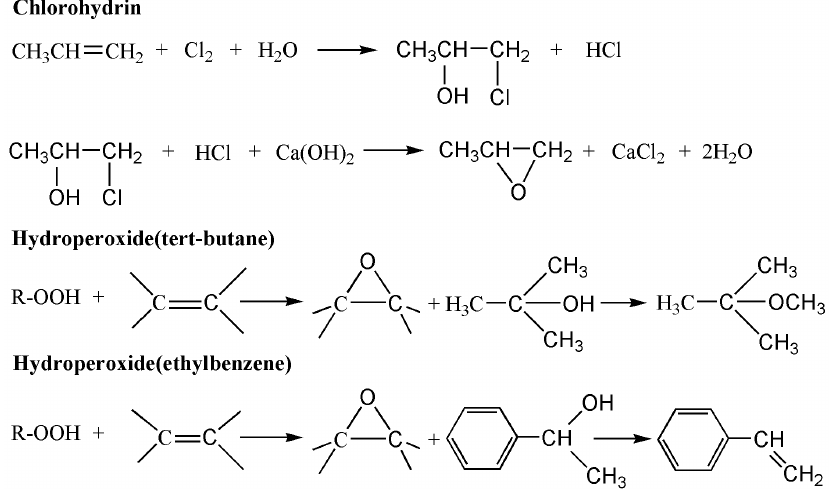
Figure 1. Reactions used in the commercial production of PO.